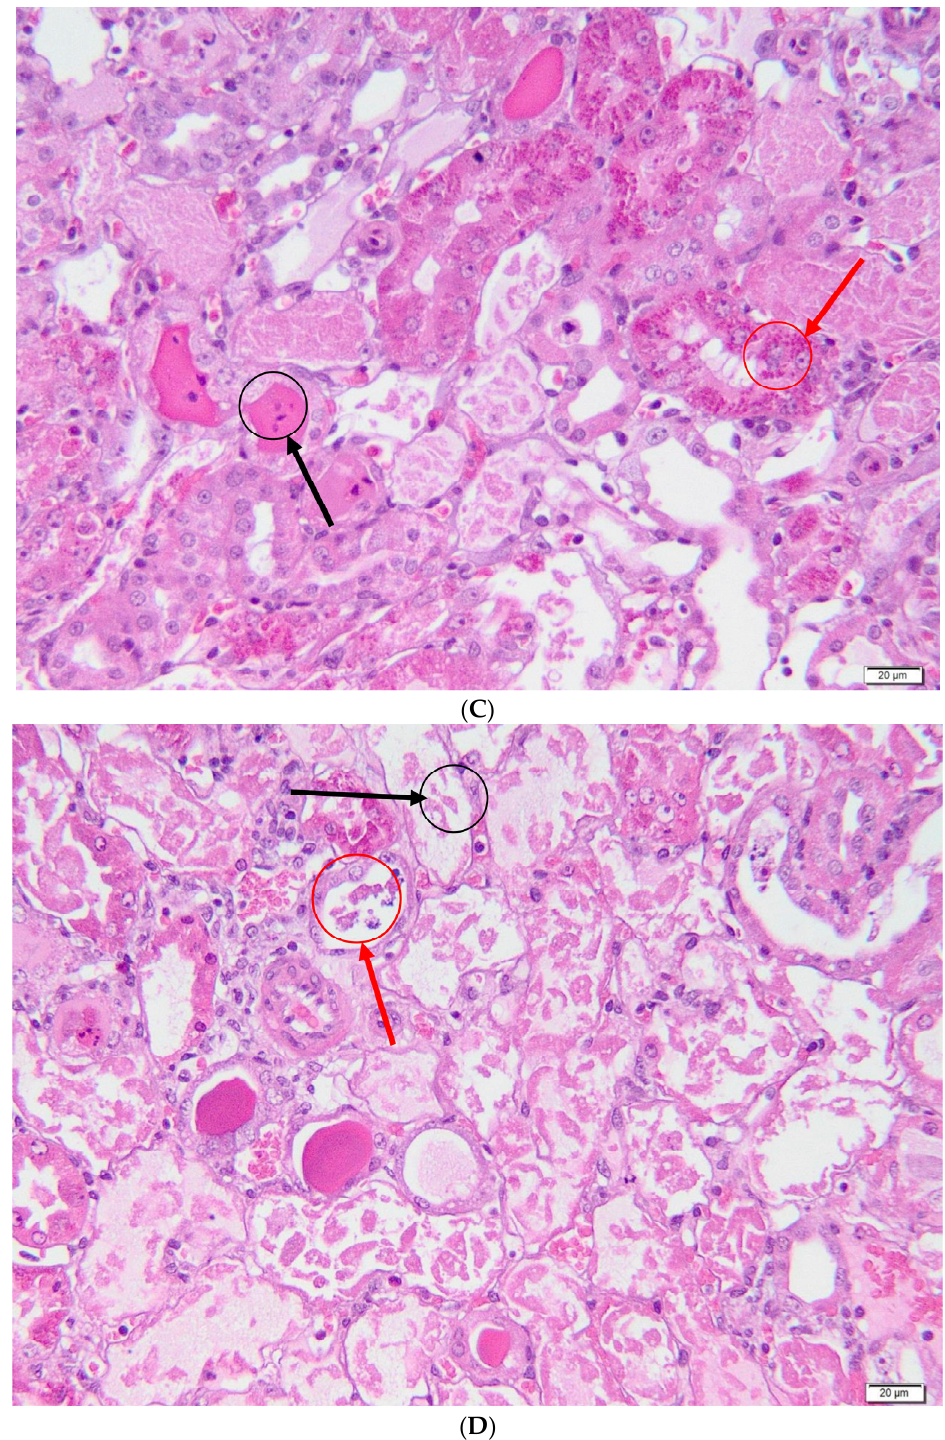
Figure 5. Gentamicin group — histological aspects. ( A ) — Loss of the brush edge of the renal epithelial cells (red arrow), associated with dilation of the lumen of the renal tubules, hydropic degeneration (blue arrow), thickening of the Bowmann capsule and glomerular atrophy (black arrow); ( B ) — Severe multifocal tubulo-interstitial nephritis with extension in the periglomerular area; ( C ) — Extracellular and intracellular hyalinosis (red arrow), with the formation of hyaline cylinders (black arrow); ( D ) — Renal tubular necrosis (black arrow), focal-extensive, acute, severe with the presence of numerous cellular detritus in the renal tubules and thickening of the basement membrane (red arrow).